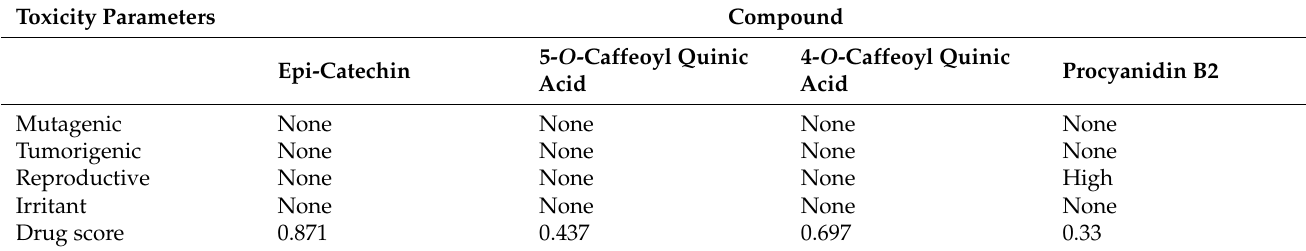
Table 4. Toxicity prediction of compounds isolated from BK(B).